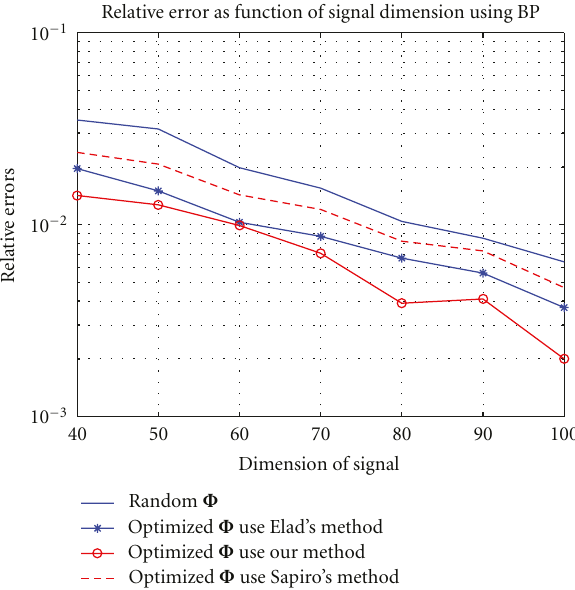
Figure 6: Relative errors as function of signal’s dimension n using BP.